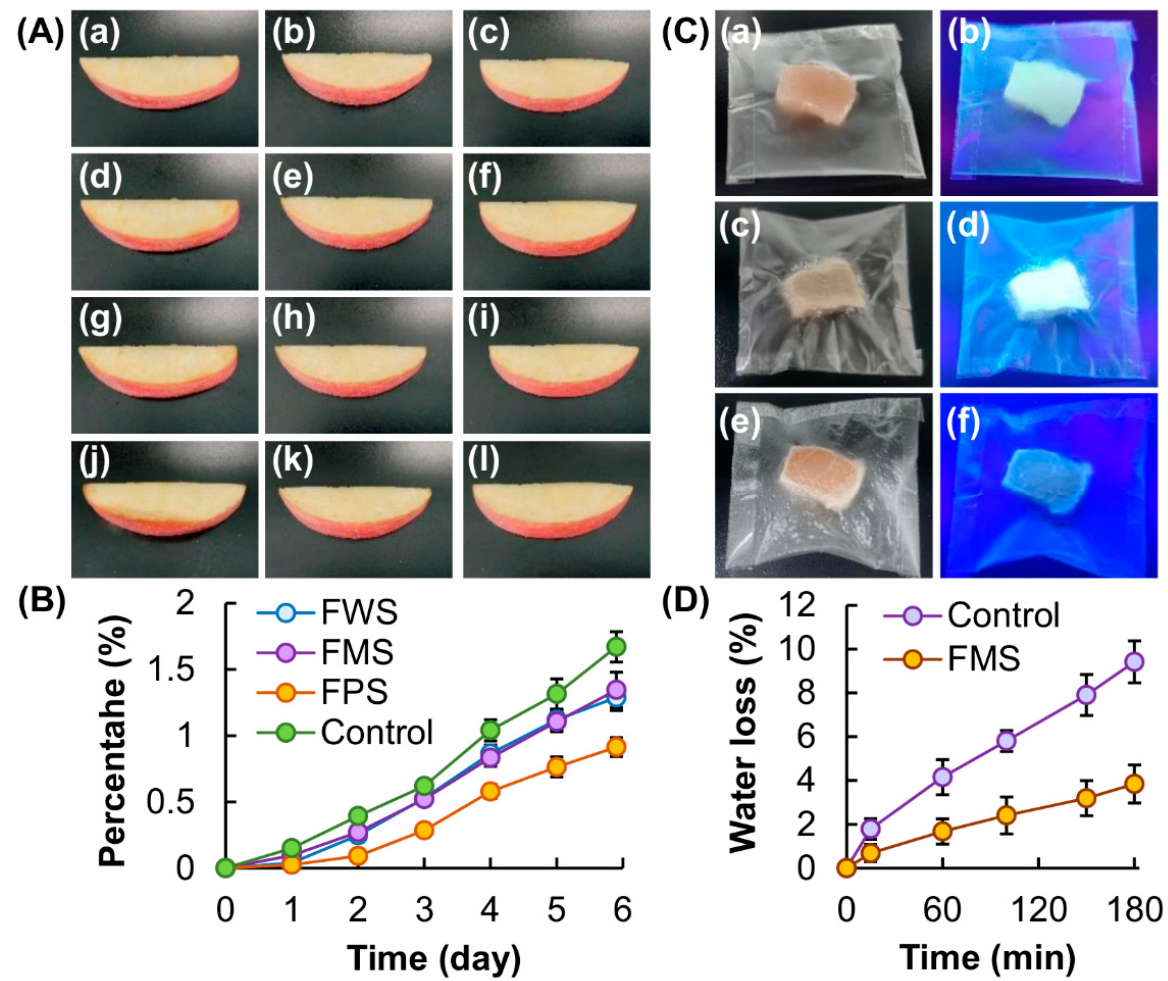
Figure 5. ( A ) Photos of an apple piece stored in a tube with the hole either ( a – c ) uncovered or ( d - l ) protected by different films (( d – f ) FWS, ( g – i ) FMS and ( j – l ) FPS) at 4 °C for ( a , d , g , j ) 0 days, ( b , e , h , k ) 3 days and ( c , f , i , l ) 6 days. ( B ) Changes in the weight of an apple piece stored in a tube with the hole either uncovered (control) or protected by different films. ( C ) Photos of a starch-based pack- aging bag containing ( a , b ) fresh chicken meat, ( c , d ) frozen chicken meat and ( e , f ) thawed frozen chicken meat under ( a , c , e ) white light and ( b , d , f ) UV light. ( D ) Time-dependent changes in the wa- ter content of the meat stored inside an FMS-generated packaging bag. Meat stored in open air is used as a control.